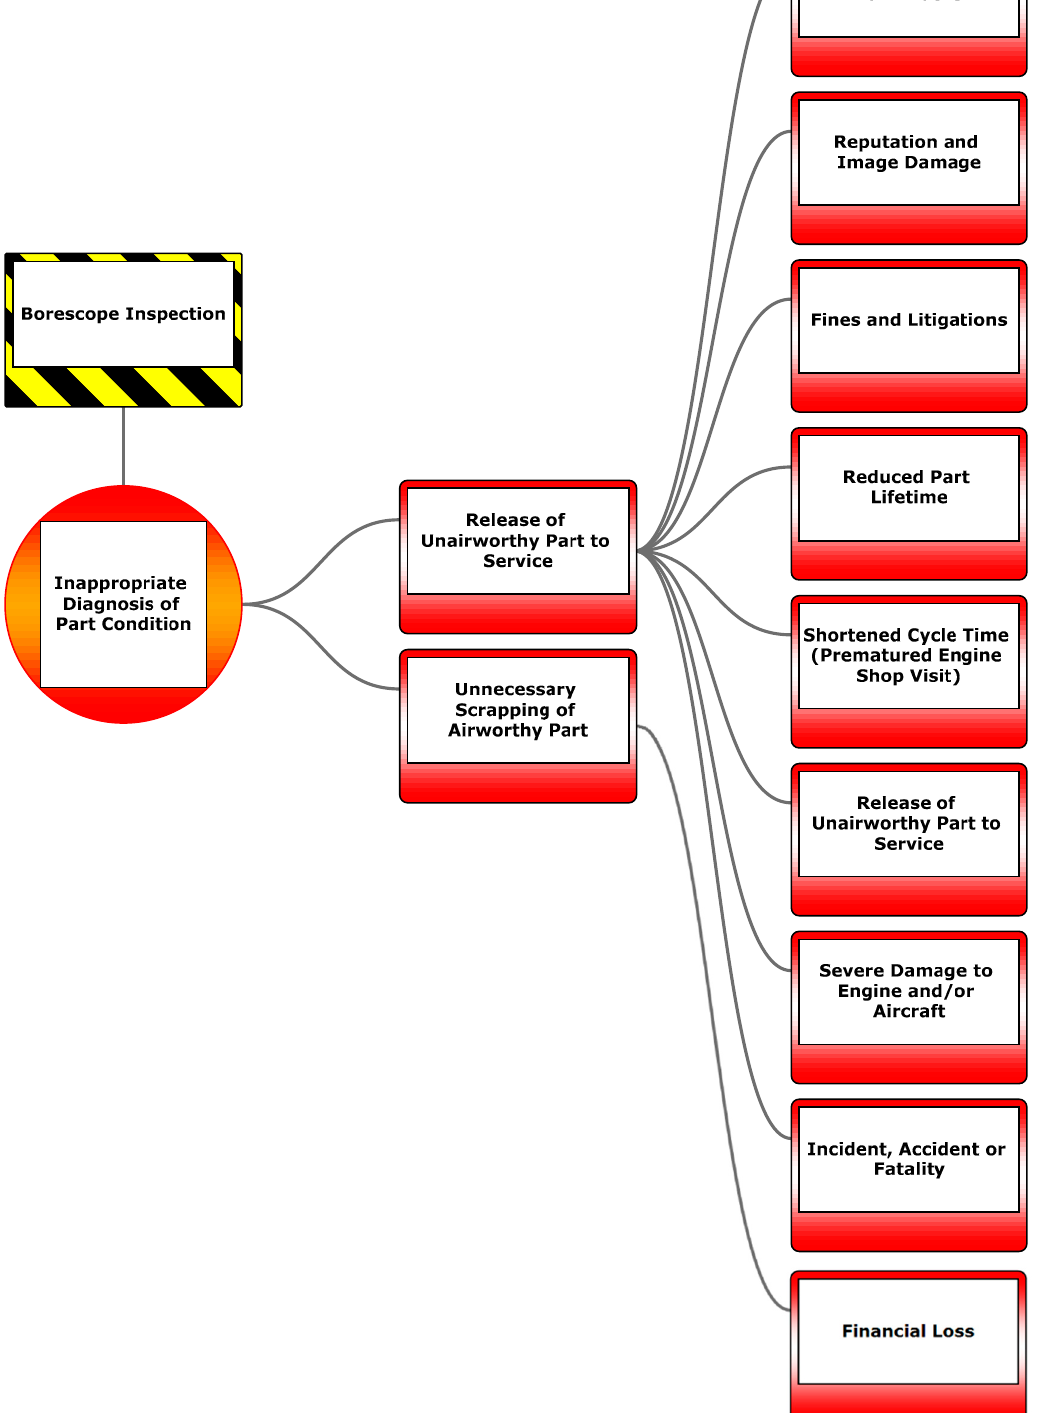
Figure 4. Bowtie diagram for “inappropriate diagnosis of part condition” with immediate and manually added subsequent consequences.